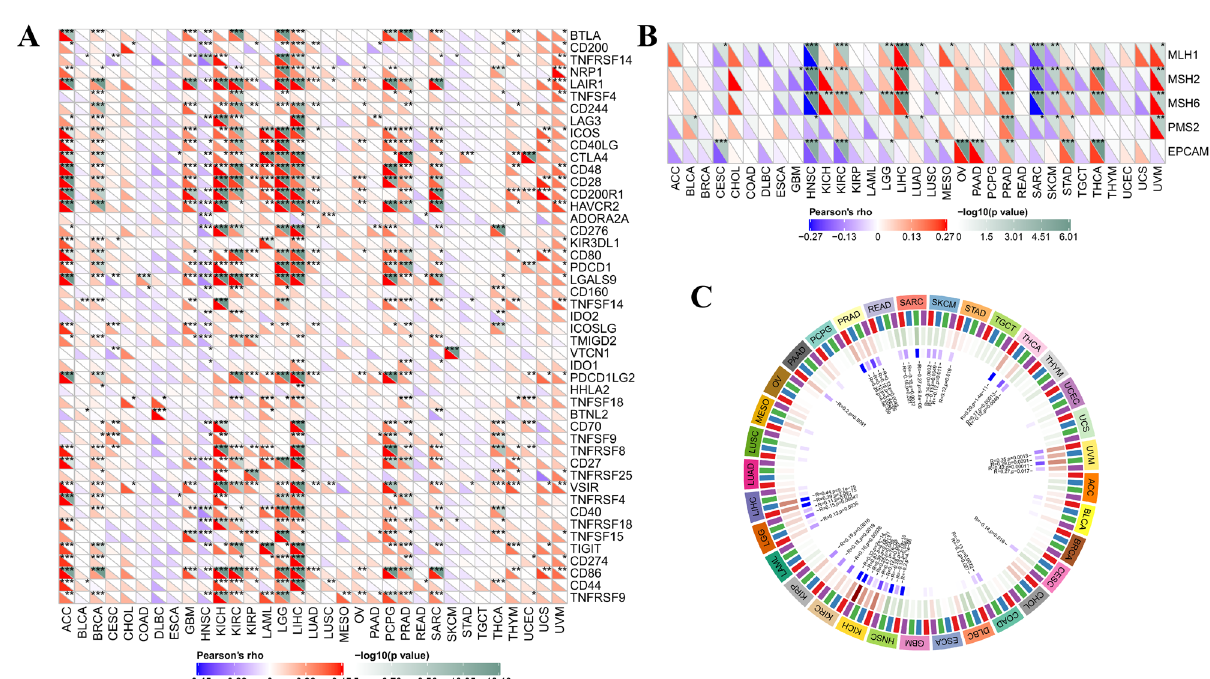
Figure 9. Correlation analysis of GSDMA expression with the expression levels of 40 common immune checkpoint genes ( A ), DNA mismatch repair (MMR) genes ( B ), and methyltransferases ( C ) in pan-cancer; The red and blue represented the positive or negative correlation, respectively ( A , B ); Red, blue, green, and purple represented DNMT1, DNMT2, DNMT3a, or DNMT3b, respectively ( C ). P < 0.050, P < 0.010, and P < 0.001were denoted by “*”, “**”, and “***”,